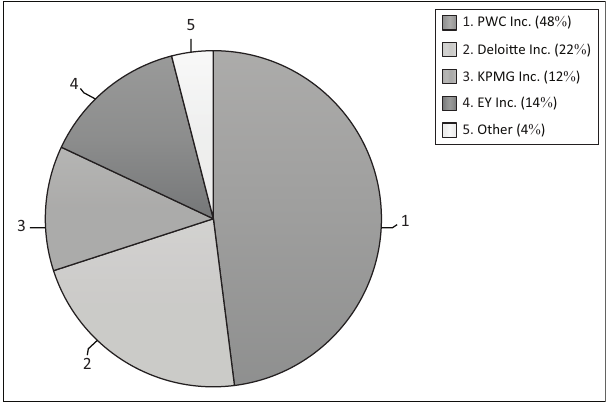
FIG URE 2: Market concentration of listed companies in South Africa measured by market